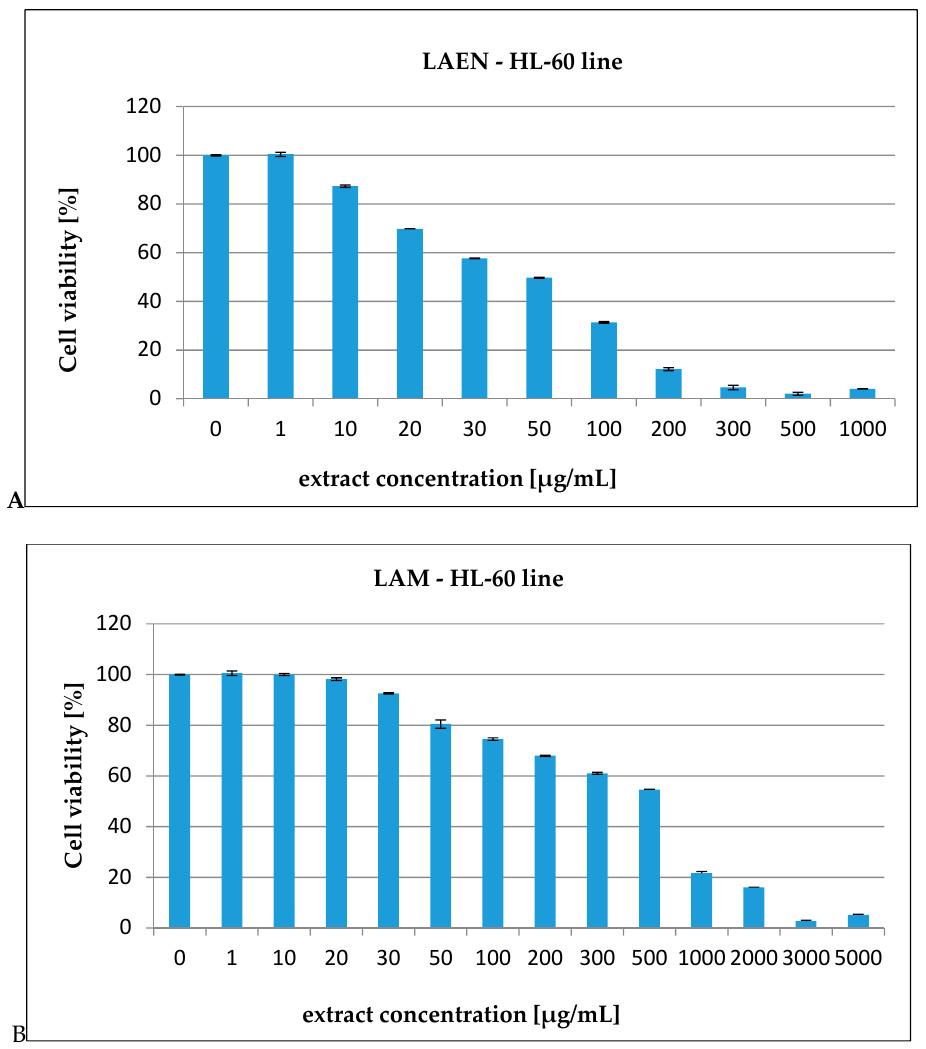
Figure 3. The valuation of the HL-60 cell line viability exposed to 24 h of increasing concentrations of: ( A) — LAEN extract and ( B ) — LAM extract.